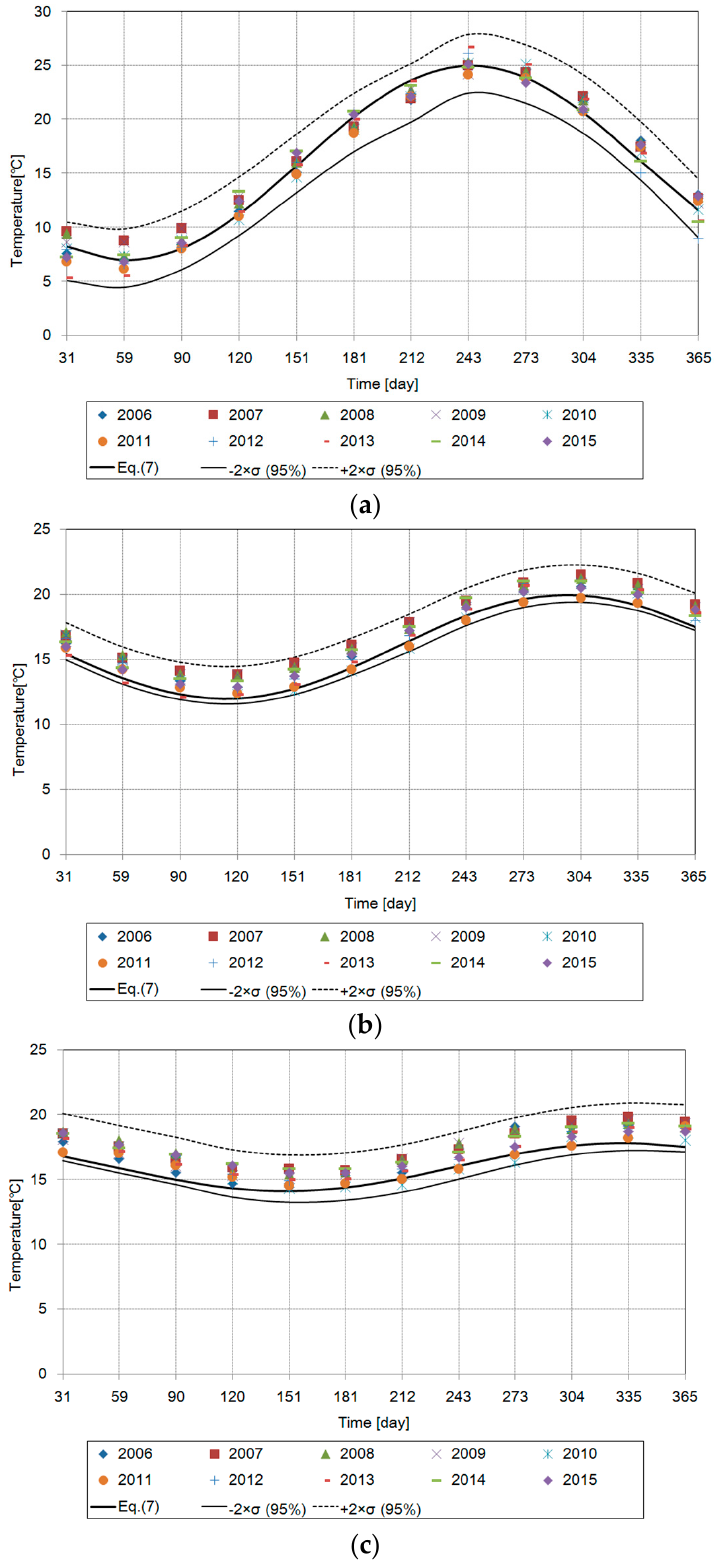
Figure 7. Comparison of experimental and predicted ground temperature distributions in Yeosu, Korea: ( a ) depth of 1 m; ( b ) depth of 3 m; ( c ) depth of 5 m.